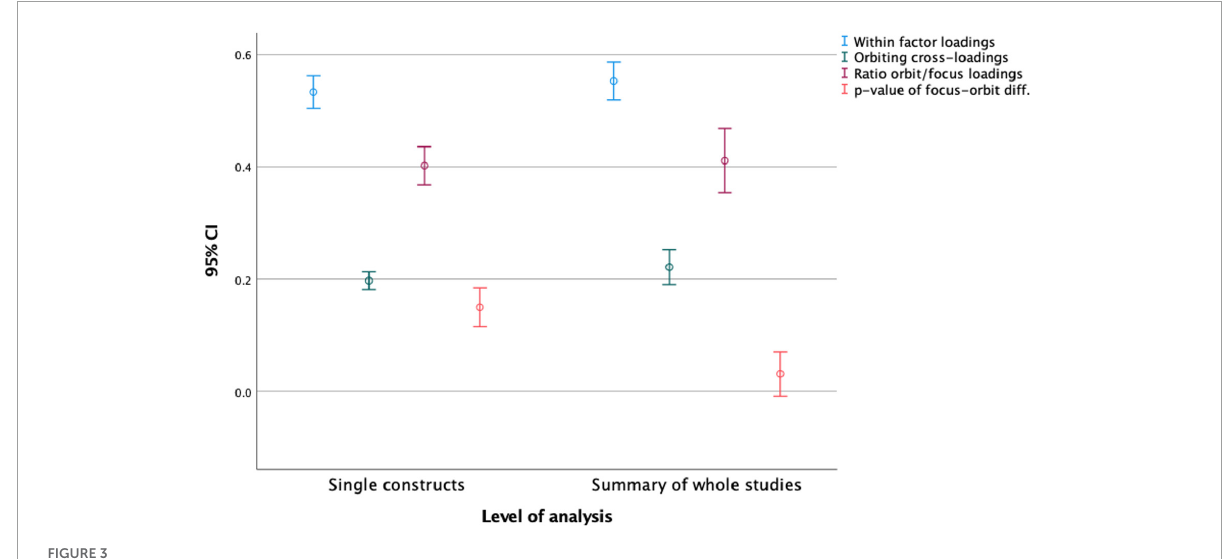
FIGURE3 Means for focus and orbiting construct factor loadings, orbit to focus ratio and P -values.